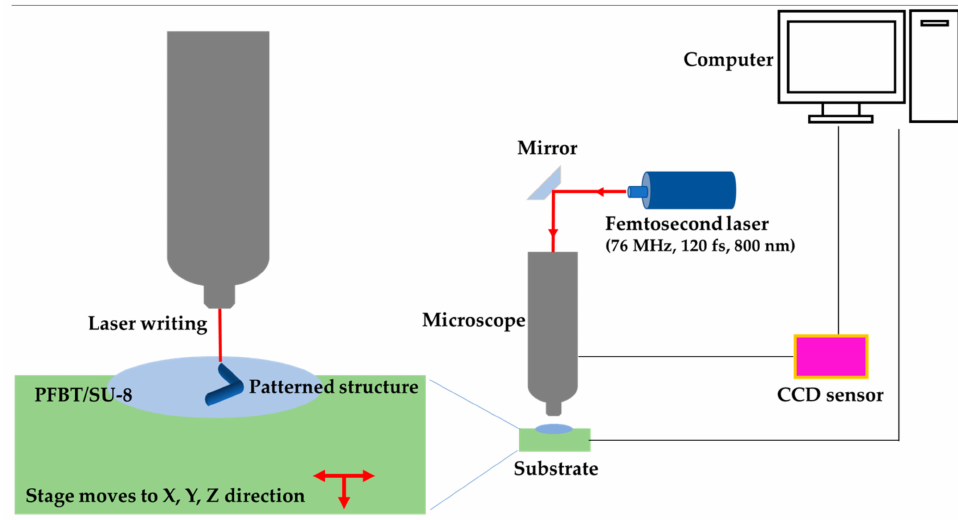
Figure 2. Two-photon lithography setup with a movable